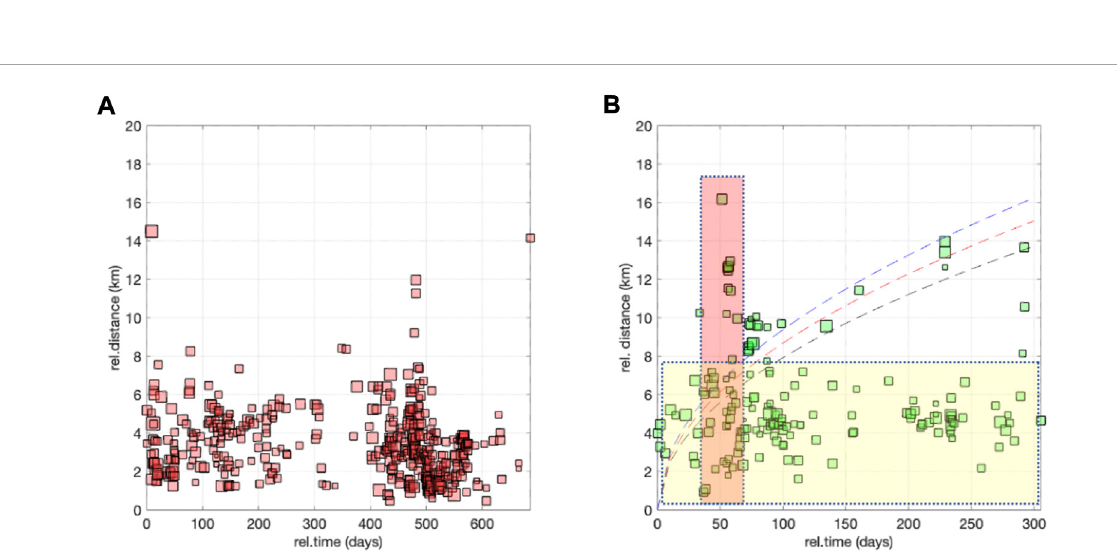
we fi nd that for real-time seismicity monitoring, where it is important to rapidly recognize variations in seismicity characteristics, δ Be can be a very useful parameter, as suggested by Picozzi et al. (2021a).